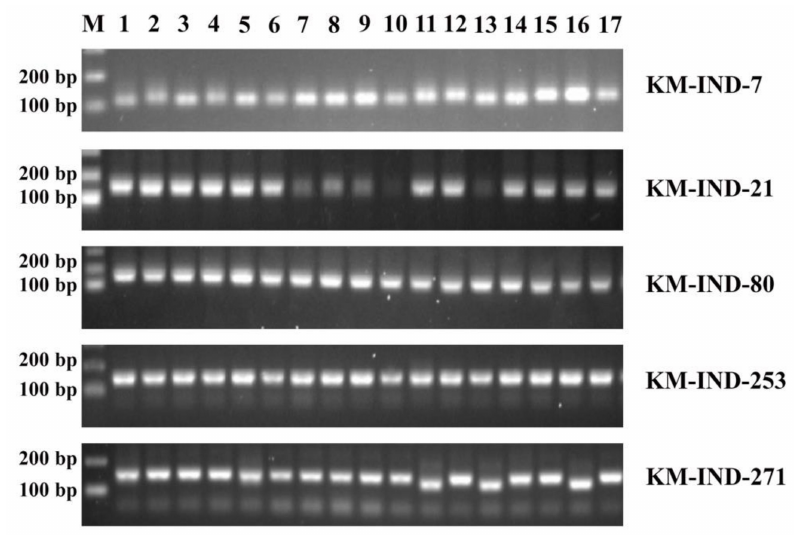
Figure 2. Electrophoretograms for five InDel markers. M, Molecular marker (a 100-bp DNA ladder). 1–17: Chinese commercial rice cultivars (see Table 2).